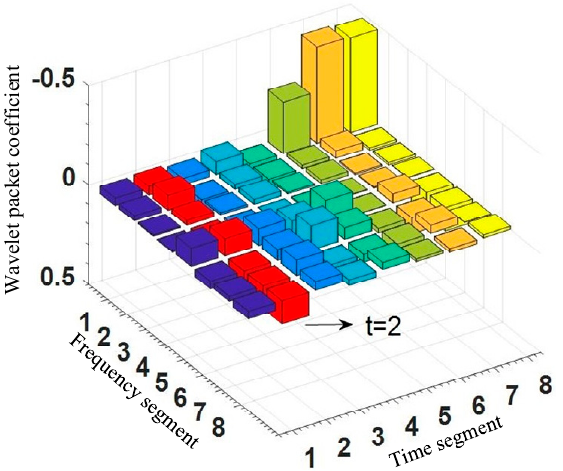
Figure 4. Schematic diagram of the three-layer wavelet packet decomposition example.